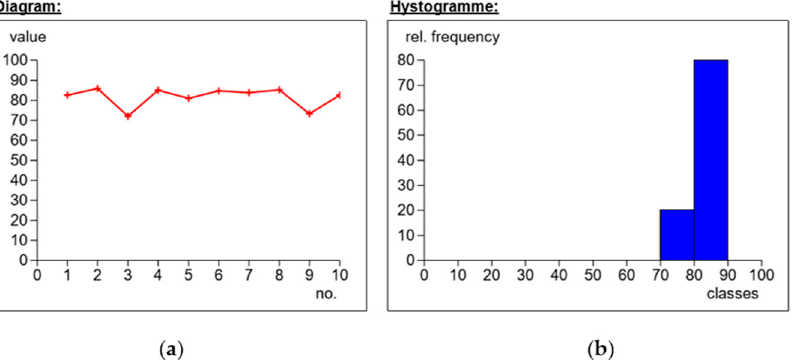
Figure 8. Application of Dialead K63712, weave 0/+ 90°, MGS L285/H285 warp: ( a ) dependence of hardness on the number of measurements; ( b ) percentages of hardness.